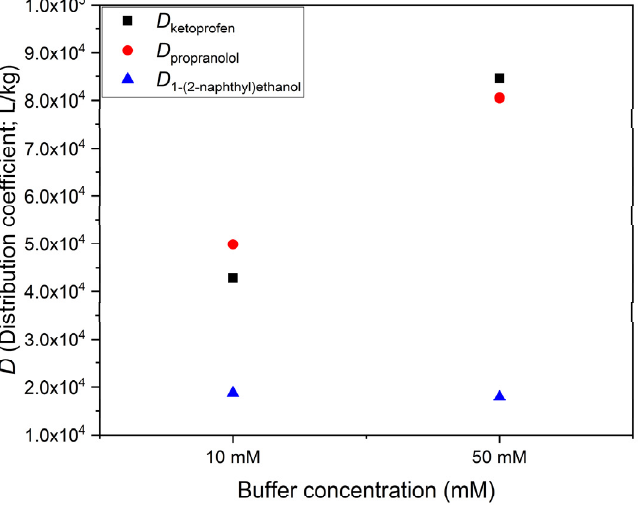
Figure 5. Buffer concentration effect on the distribution coefficients of ketoprofen, propranolol, and 1-(2-naphthyl)ethanol. The 1-(2-naphthyl)ethanol was measured in a 20% methanolic buffer at pH 7.0 (blue). Propranolol was measured in an aqueous buffer at pH 4.3 (red). Ketoprofen was measured in an aqueous buffer at pH 8.0 ( black ).